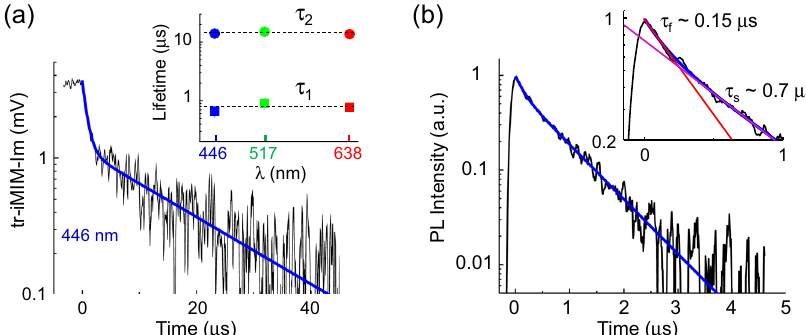
Fig. 2 Time-resolved iMIM and carrier lifetime. a Typical tr-iMIM relaxation curve of Sample A. The sample was illuminated by the 446-nm laser at P = 100 mW/cm 2 before t = 0 μ s. The inset shows the two lifetimes under excitation lasers with wavelengths of 446, 517, and 638 nm. b TRPL data of C Sample A. The blue curve is a biexponential fi t to the TRPL data. The inset is a close-up view, showing the two decay time constants from the fi tting.